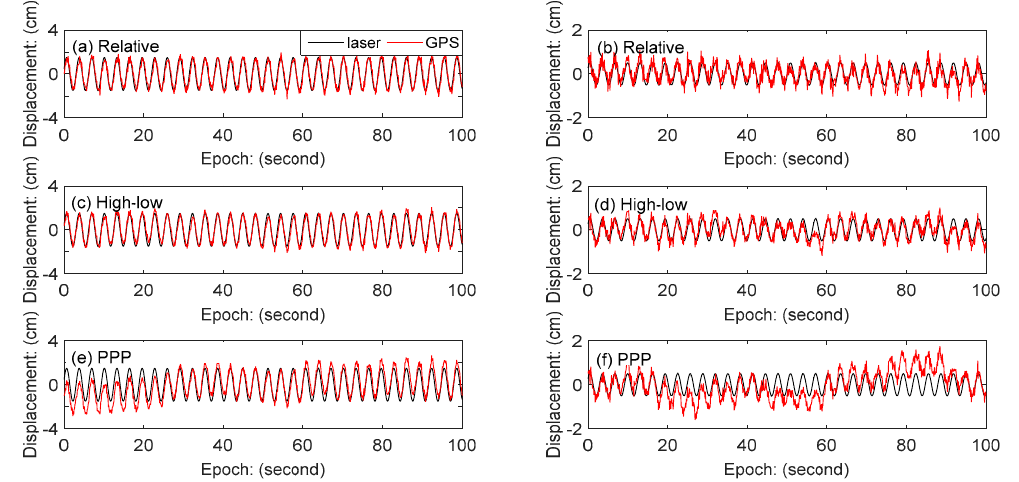
Figure 5. Comparison of N-direction displacement observed by GPS and laser sensor, with the results of the amplitude 15 mm on the left and the results of the amplitude 5 mm on the right: ( a , b ) relative positioning method, ( c , d ) combining high- and low-rate GPS method, ( e , f ) PPP method (note the y-axis scales are different).